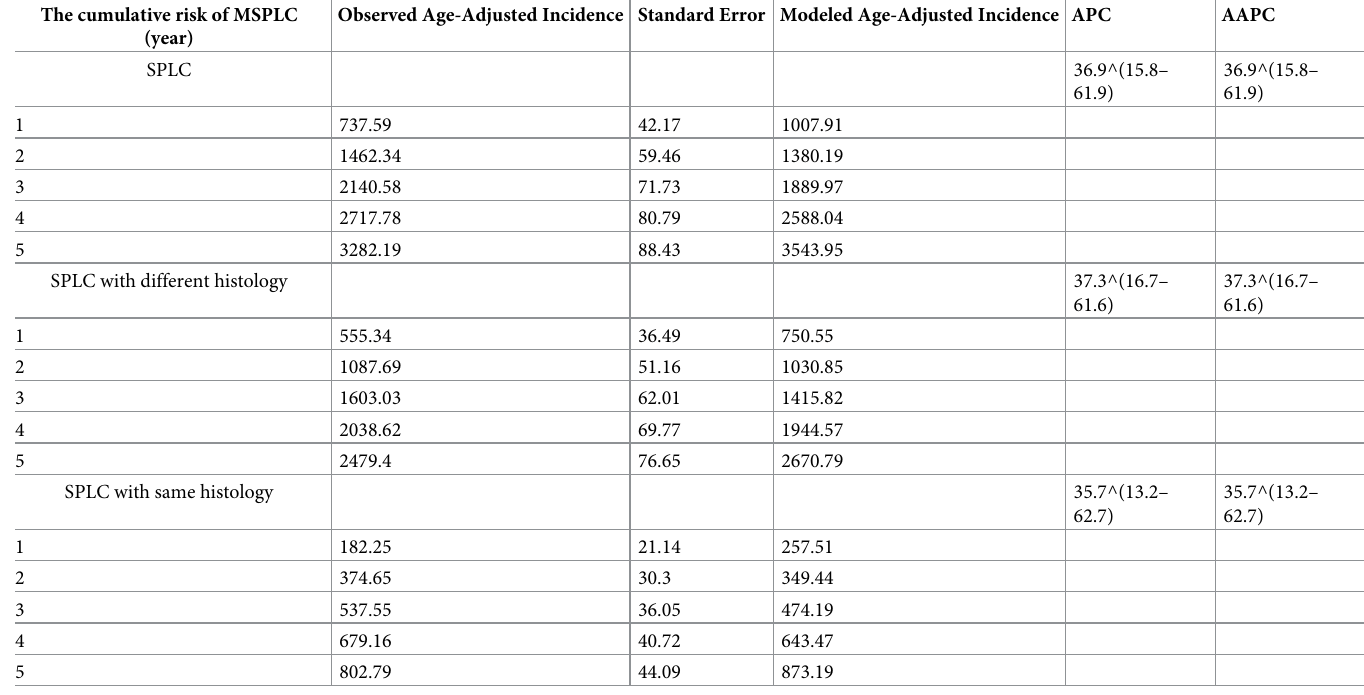
prediction nomogram of metachronous SPLC, with the risk of 0.01 to 0.11(Fig 2). Our risk nomogram showed moderate discrimination (C-index = 0.67). In the internal validation, C- index of risk model was still 0.67. Calibration curve indicated good calibration between actual probability and was able to predict the probability of our risk models for predicting metachro- nous SPLC(Fig 3). In terms of age variable, the patients aged less than 50 or more than 80 years exhibited lower risk of SPLC than those aged 60 to 79 years. In terms of histological Table 2. Incidence trends of metachronous second primary lung